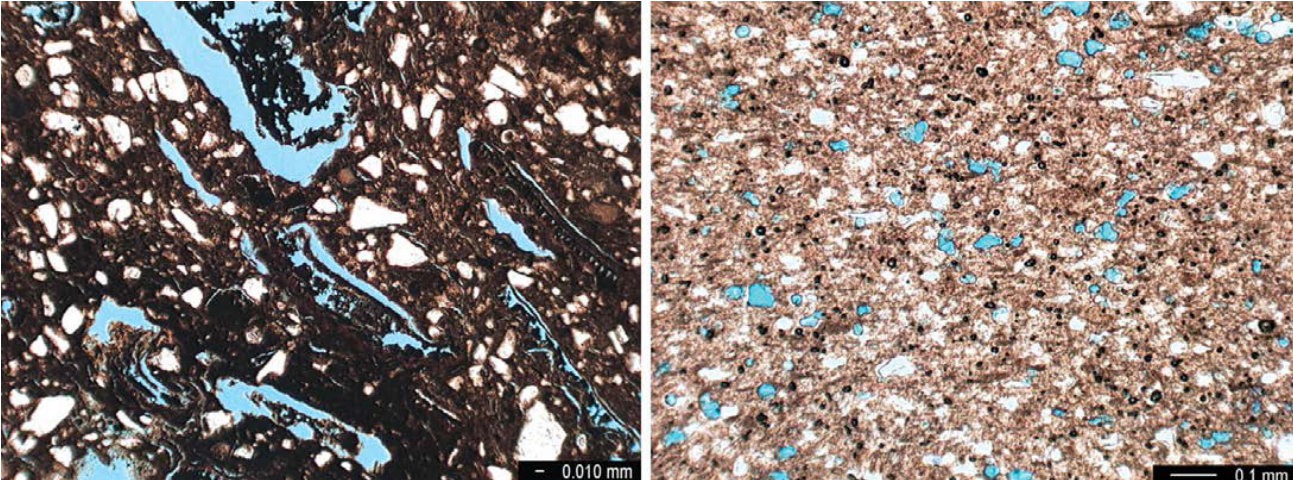
Figure 1. Typical pore size, shape, and homogeneity of a low-fired organic tempered ceramic ( left ) versus a high-fired fine-sand tempered ceramic ( right ). Thin sections mounted in blue-dyed epoxy and viewed in plane polarized light.